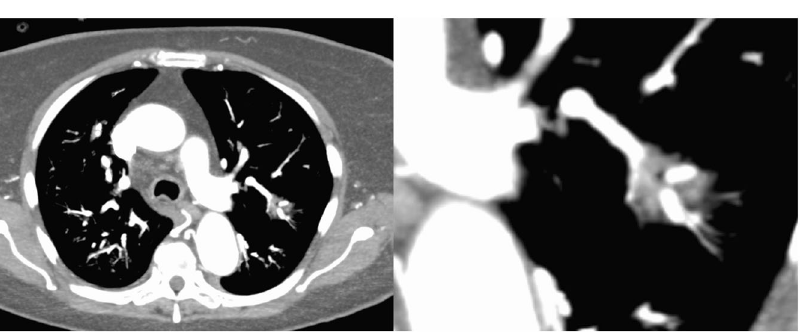
Figure 2. Overview (left) and close-up (right) computed tomography pulmonary angiography images of a 53-year-old immunocompromised patient due to kidney transplantation. The images demonstrate the vessel interruption within the sub-solid